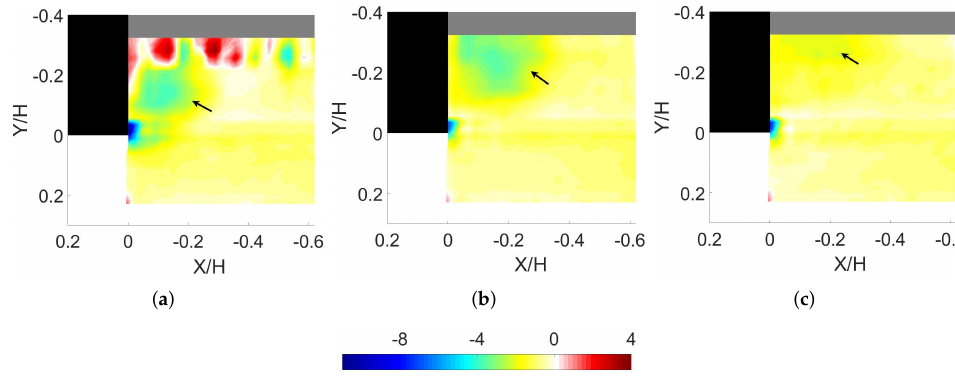
= 0.19, ( b ) Z = 0.28, and H H